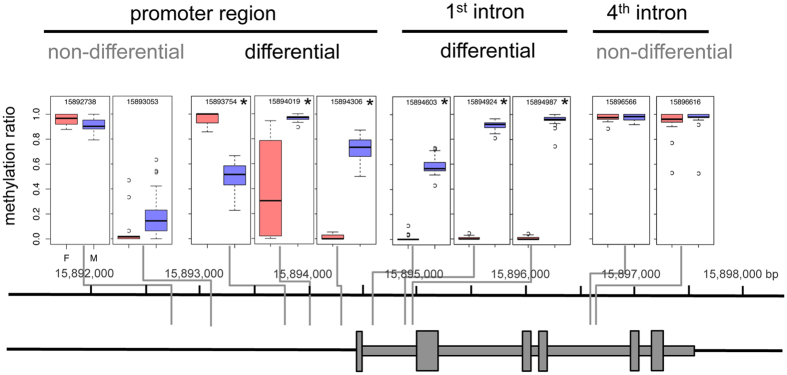
Map of CG methylation across the PbRR9 gene (Potri.019G133600).Pink = female; blue = male. There is strong sex-specific methylation in the putative promoter region and in intron 1. In addition there is strong non-sex-specific methylation in intron 4. Asterisks indicate a significant difference between male and female samples (Q < 0.001, logistic regression test (Akalin et al.42), n = 18–24, methylation difference >20%).